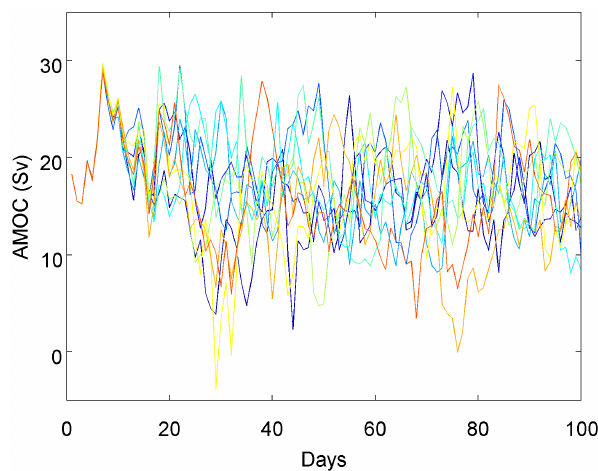
Figure 1. 26.5 ◦ AMOC time series of the ensemble spread for the first 100 days after the initialization of the ensemble in year AD1600, measured in Sverdrups (1Sv = 10 6 m 3 s − 1